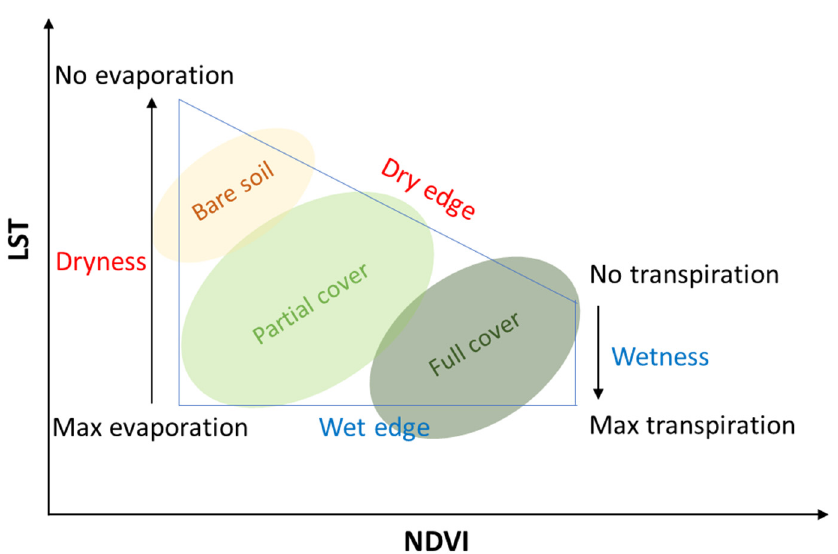
Figure 1. LST–NDVI trapezoid, describing the transition of full coverage to the bare soil and the interpretation of the pixel’s position inside the trapezoid.